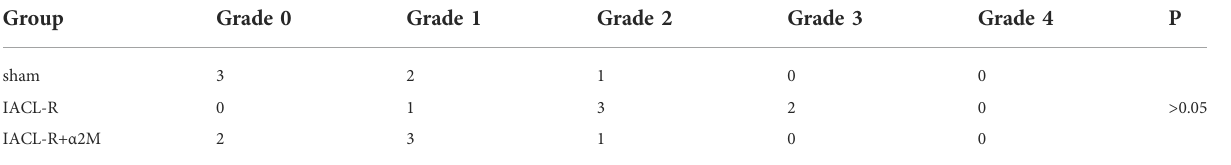
TABLE 2 Kellgren-Lawrence grades on X-ray examination at 3 months ( n = 6).